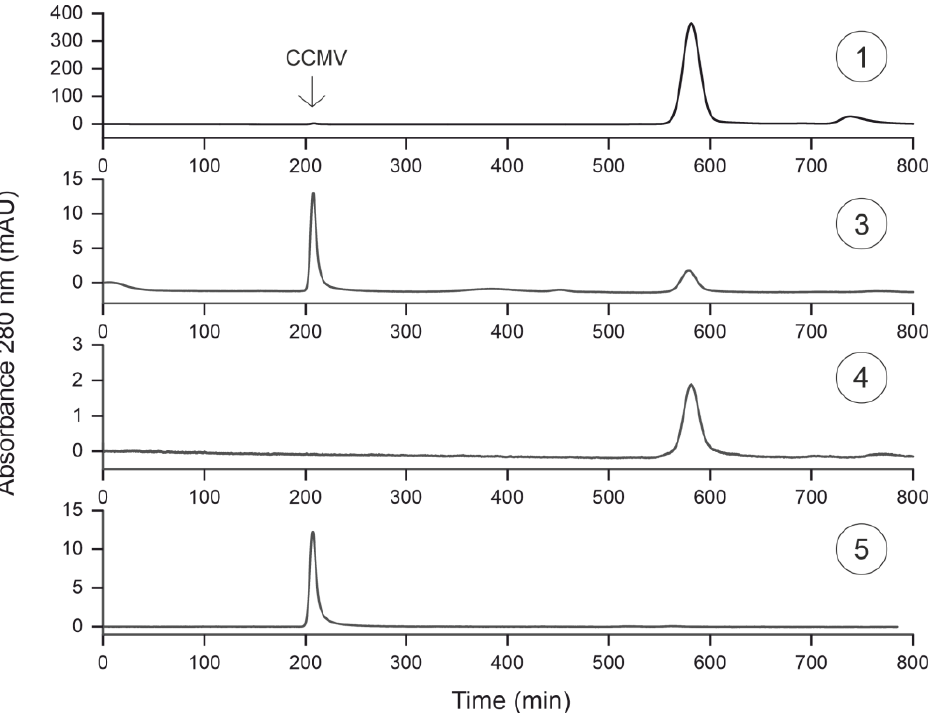
Figure 9. Size exclusion chromatograms (SEC) of samples taken at different steps of the purification protocol are shown in Figure 7: 1 (cid:13) crude extract; 3 (cid:13) filtered supernatant after pelleting with PEG 8000; 4 (cid:13) flowthrough of the affinity extraction; 5 (cid:13) eluate of the affinity extraction. SEC was performed with a Hi Prep 26/60 Sephacryl S-300-HR, Cytiva (17119601); the running buffer was 0.05 M sodium acetate buffer, 0.15 M NaCl and 1 mM Na 2 EDTA, pH 4.8, with a flow rate of 0.5